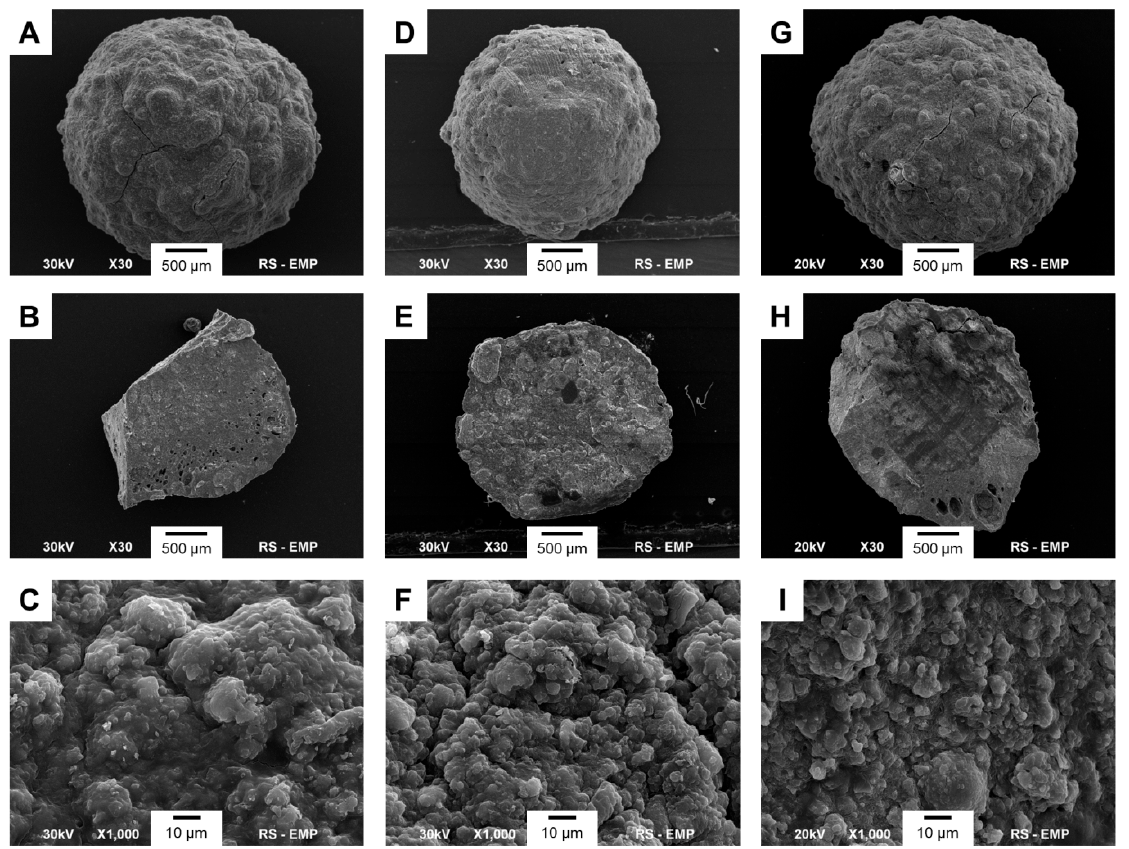
Figure 2. SEM images of CS-RAL ( A – C ), KER-RAL ( D – F ), and CS/KER-RAL ( G – I ). First line: whole bead at × 30 magnification; second line: internal cross-section at × 30 magnification; third line: outer surface at × 1000 magnification. The same measurements were performed for control beads without the drug, but no difference in morphology was